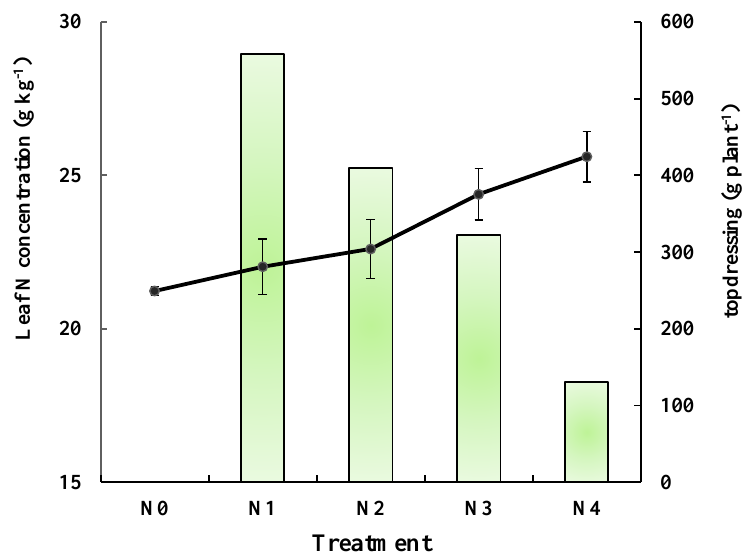
Figure 4. Leaf nitrogen concentrations determined in 2016 from spectroscopic analysis of leaves from trees receiving different controlling treatments. Points on the black line are the average leaf nitrogen concentration of N0, N1, N2, N3, and N4 (21.2, 22.0, 22.6, 24.4 and 25.6 g · kg − 1 , respectively). The green column were the urea topdressing rates calculated using the fertilizer formula. Table 5. Details of nitrogen application rates for regulatory treatments.